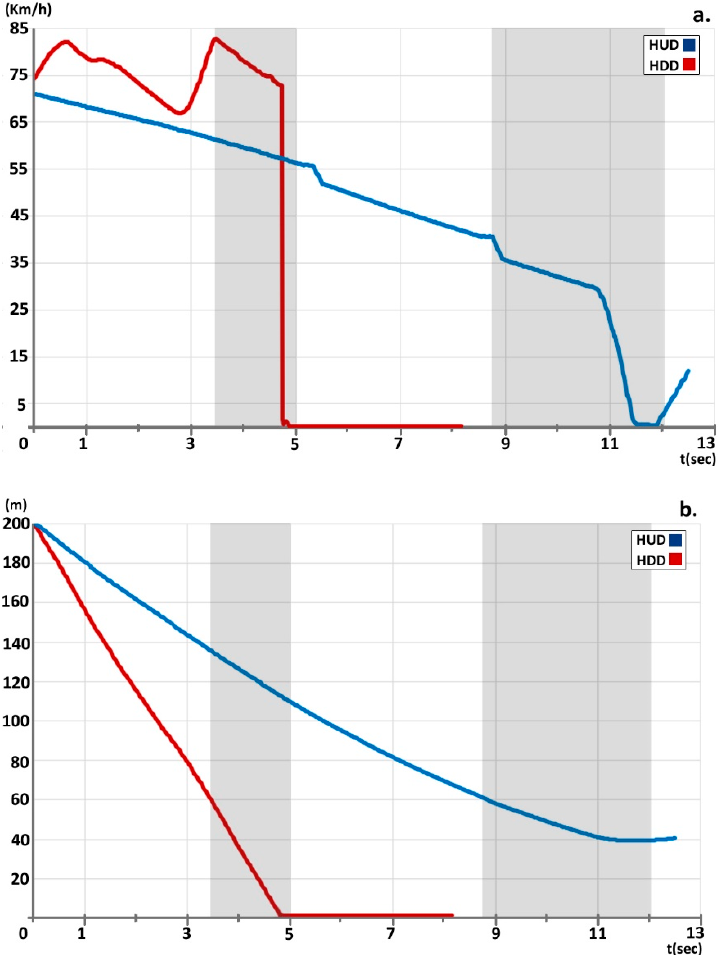
Figure 16. Driver reactions on the last 13 s of the simulation. ( a ) Vehicle speed (Km/h) over time (s), ( b ) Distance (m) from the leading vehicle over time (s).